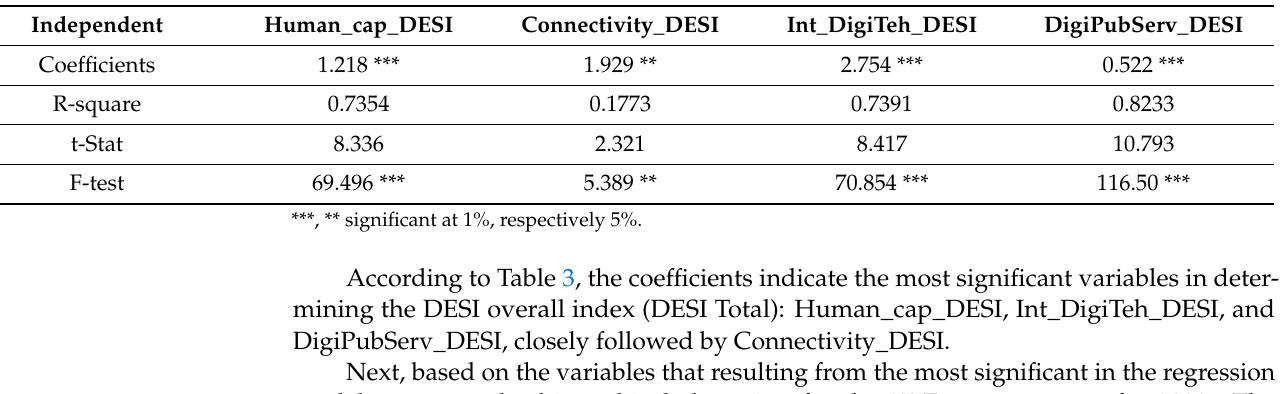
Table 3. Determination coefficients between DESI overall index (DESI Total) and DESI